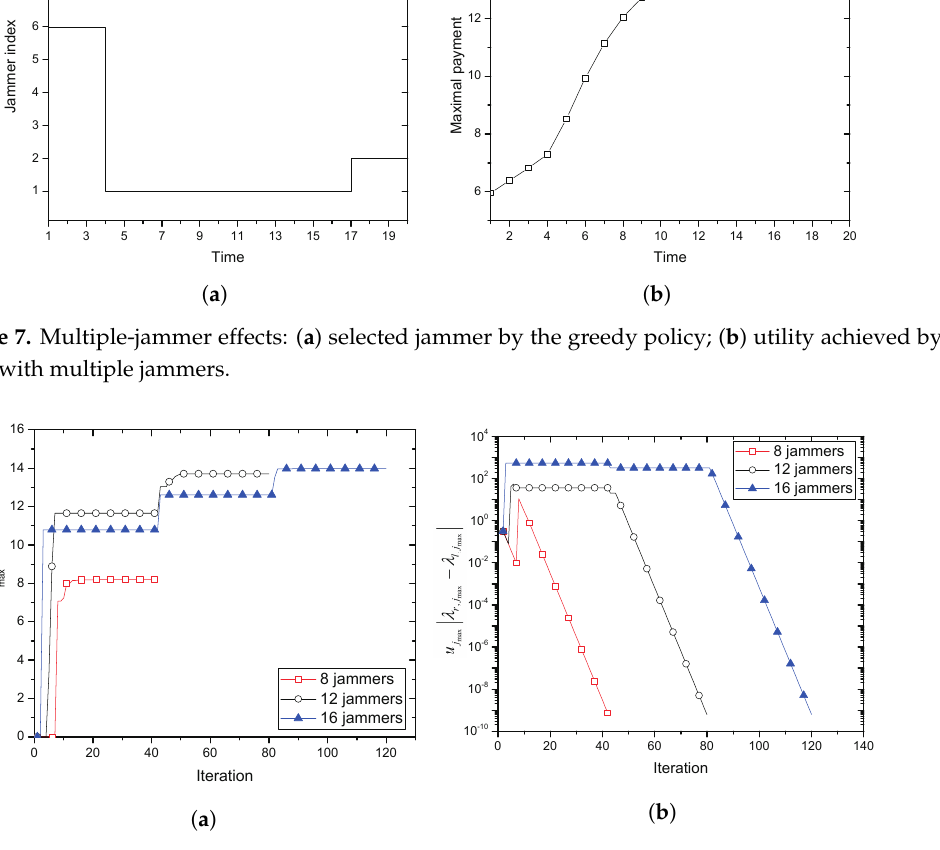
Figure 8. Convergence behavior of ICSP: (a ) payment behavior; ( b ) convergence speed.